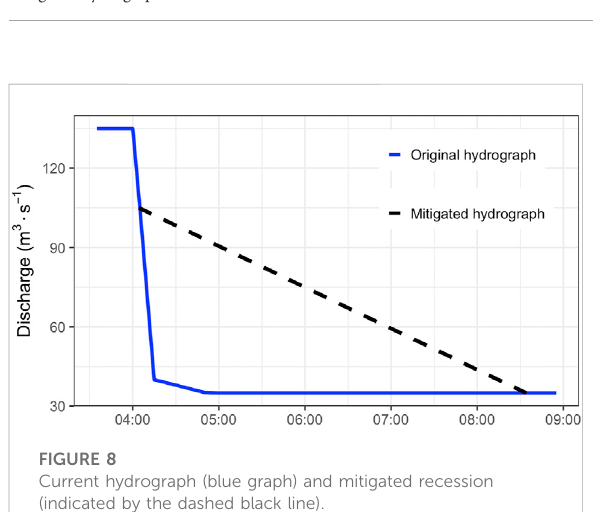
FIGURE 8 Current hydrograph (blue graph) and mitigated recession (indicated by the dashed black